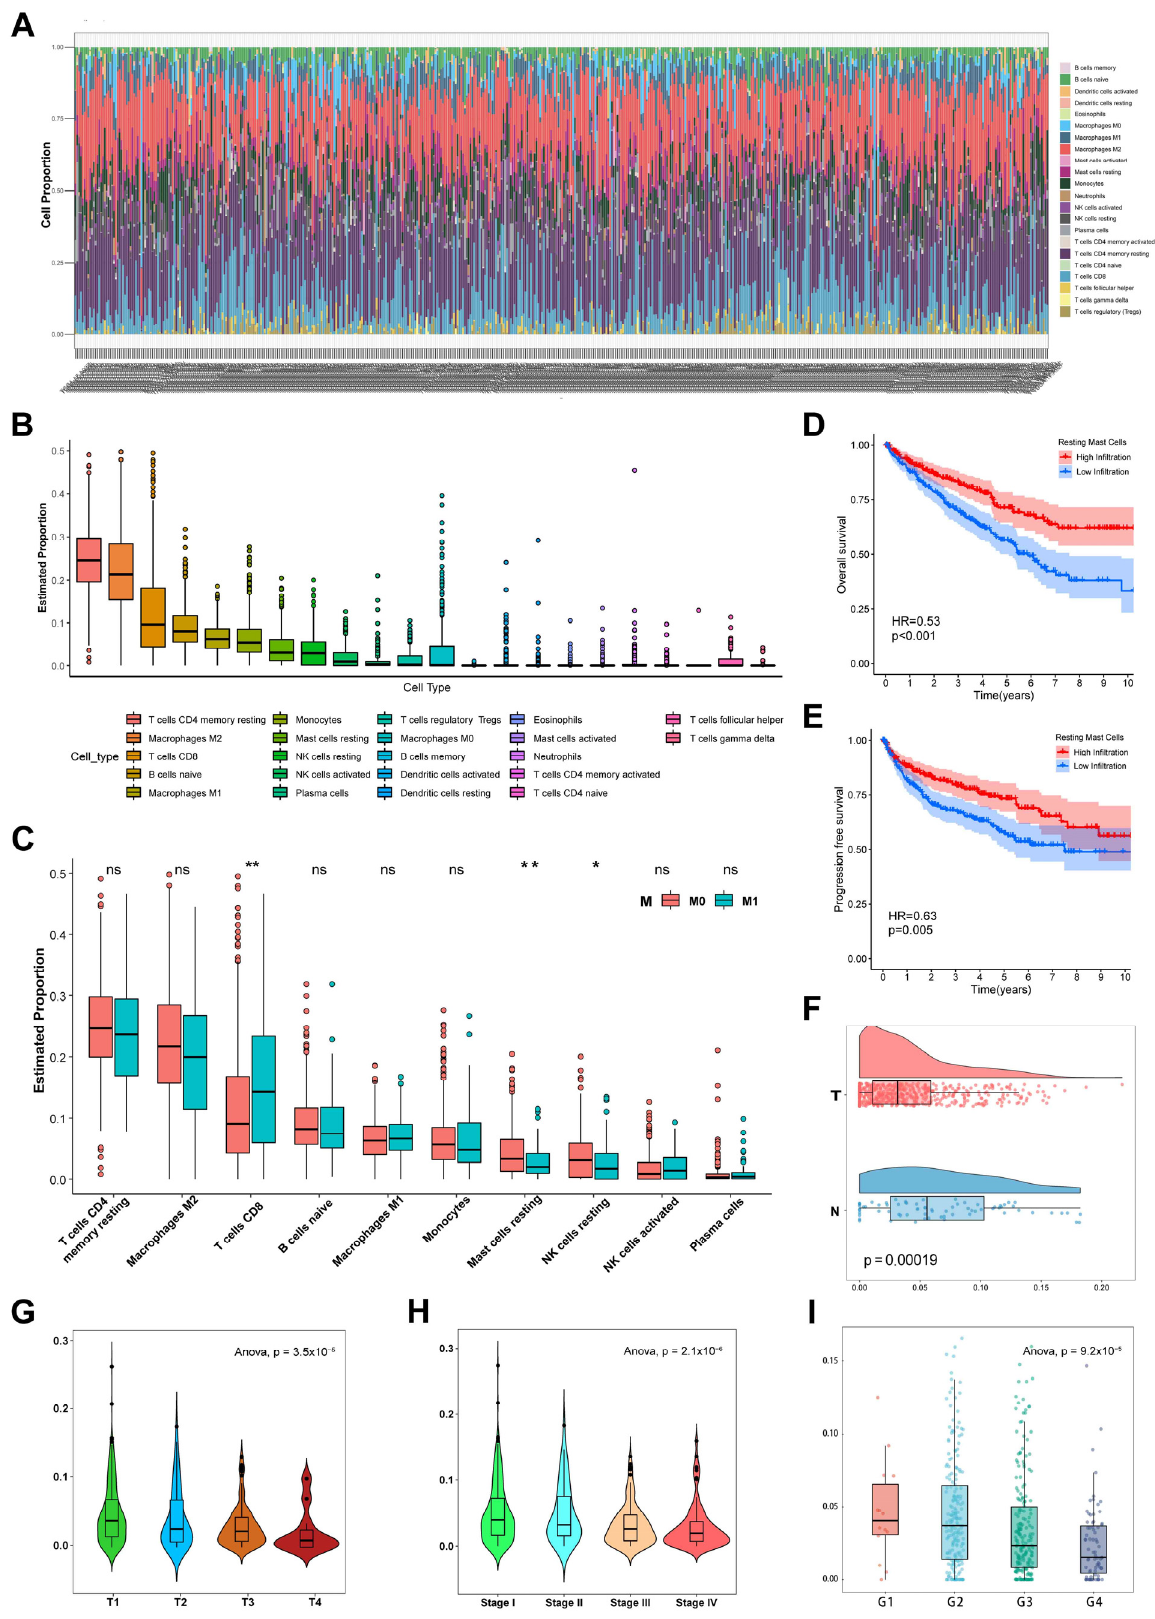
Figure 2. Identification and validation of the key TIICs. ( A ) The landscape depicts the proportions of TIICs in each ccRCC tissue. ( B ) Box plot describes the level of infiltration for the 22 TIICs. ( C )